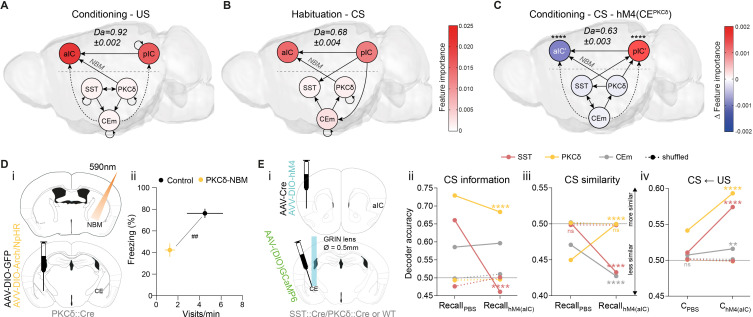
The CE–NBM pathway promotes top-down information for Pavlovian learning.(A) Network depicting significant TE after US; generated from data acquired from RC and FC. RF decoder accuracy (Da) for decoding USs at RC and FC stages shown above network. Node color corresponds to feature importance resulting from RF classification under control conditions (see Figure 2—figure supplement 2Aiv). (B) Network depicting significant TE during CS in the habituation stage. RF Da for decoding CSs at habituation. Nodes are colored according to the feature importance resulting from RF classification (see Figure 2—figure supplement 2Av). (C) Network depicting significant TE during CS generated from data acquired during RC and FC. aIC/pIC data has been replaced by a dataset recorded during chemogenetic inhibition of CEPKCδ (aIC’, pIC’) in the same animals (hM4(CEPKCδ)). RF Da for decoding CSs at RC and FC stages during hM4(CEPKCδ) shown above network. Feature importance given as differential from control conditions, with * indicating significant differences (see Figure 2—figure supplement 2Aiii). (D) (i) Experimental approach for optogenetic inhibition of the CEPKCδ-NBM pathway during CS presentations at conditioning. (ii) Quantification of approach and avoidance behavior at recall (nGFP = 7, nCE-PKCδ–NBM=6; significant MANOVA, F1,10=9.76, p=0.0045). Data presented as mean ± SEM. Holm post hoc as difference to control, ##p<0.01. (E) (i) Scheme for chemogenetic inhibition of aIC (hM4(aIC)) during CE population recordings. (ii) Mean CS Da of an MLP trained to detect CS information in the activity of 20 CESST, 30 CEPKCδ, and 10 CEm best neurons per treatment to detect CS information at recall during control conditions (PBS) and hM4(aIC) (significant treatment x population interaction in a two-way ANOVA, F5,4788=117.50, p<0.0001). (iii) Mean CS Da of an MLP trained on the activity of 20 CESST, 30 CEPKCδ, and 10 CEm best neurons per treatment to detect R(F)-CS applied on F(R)-CS at recall during control conditions (PBS) and hM4(aIC) (significant treatment x population interaction in a two-way ANOVA, F5,9588=306.50). (iv) Mean CS Da of an MLP trained on the activity of 20 CESST, 30 CEPKCδ, and 10 CEm best neurons to detect R-US or F-US applied on R-CS or F-CS, respectively, in the conditioning stages during control conditions (PBS) and hM4(aIC) (significant treatment x population interaction in a two-way ANOVA, F5,9588=163.90, p<0.0001). * Indicates significant differences between treatments within population, as determined by Holm-Sidak post hoc analysis, ****p<0.0001. Only non-significant differences to shuffled data are explicitly indicated (‘ns’). Full statistical report in Appendix 1—table 1.Figure 5—source data 1.Decoding accuracy of an MLP classifier on single neuron activity of CE populations.Bold rows indicate neurons used as ‘best neurons’ in Figure 5E and Figure 5—figure supplement 5.Figure 5—source data 2.Approach and avoidance behavior during the optogenetic CEPKCδ–NBM manipulation cohort during recall.